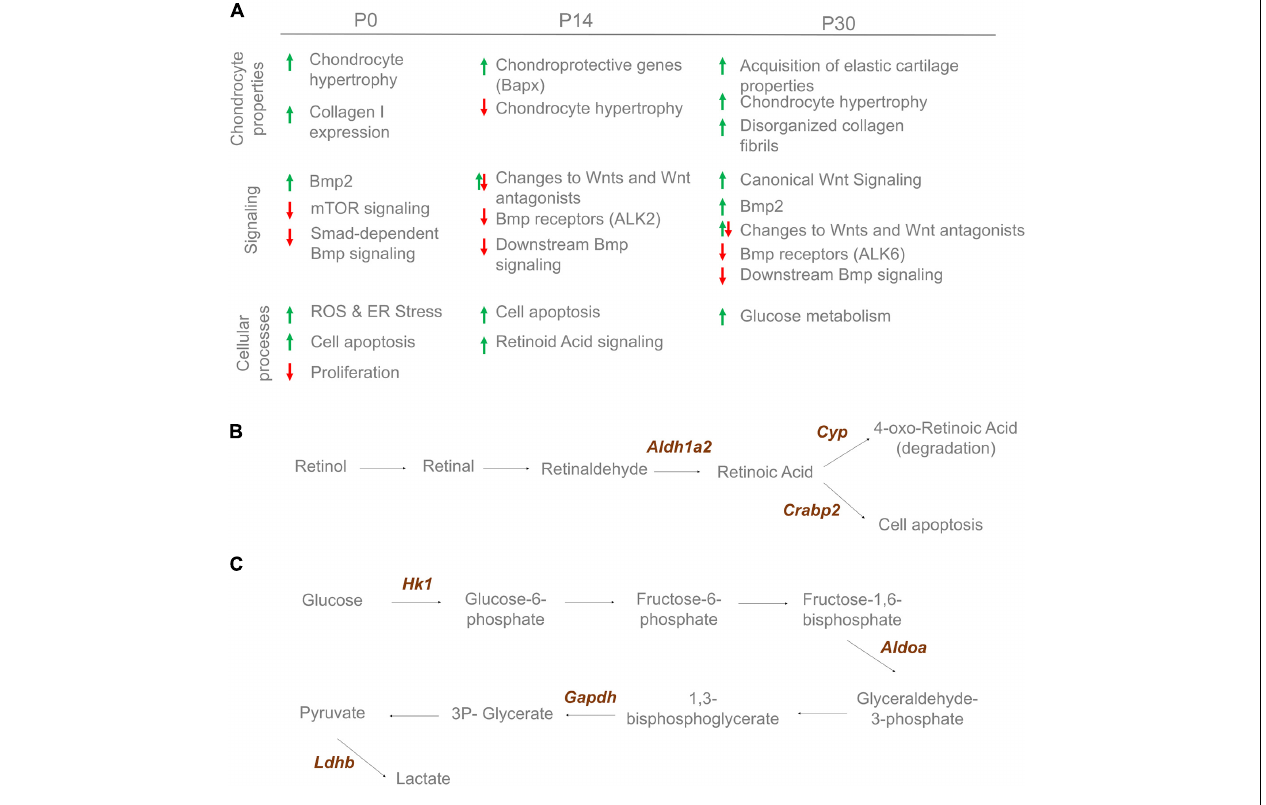
FIGURE 9 | Cartilage changes observed in Bmp7 ncko mice. (A) Altered cartilage properties, signaling and cellular processes observe over-time in Bmp7 ncko mice. Proteomics analysis revealed proteins involved in retinoic acid signaling at 2 weeks (B) and glucose metabolic process at 4 weeks (C)